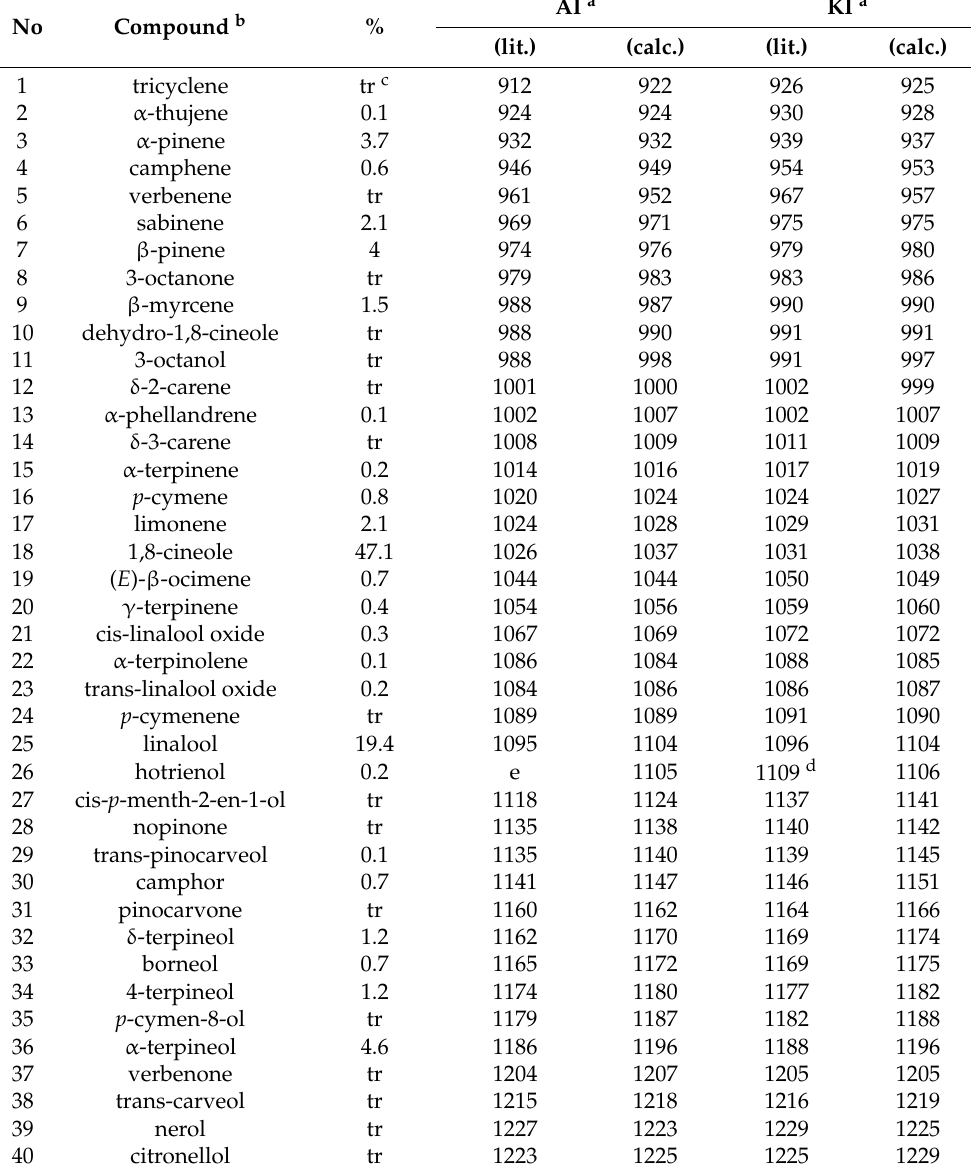
Table 1. Volatile composition of essential oil of T. mastichina